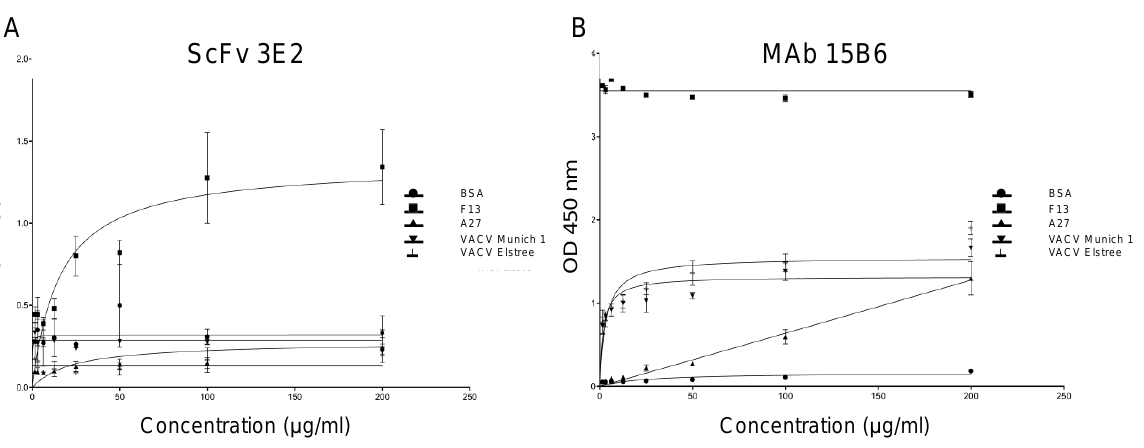
Figure 2. Binding affinities of the scFv 3E2 ( A ) and mAb 15B6 ( B ) as measured in an indirect ELISA using recombinant F13, A27 proteins of VACV, VACV Elstree, Munich1 or BSA. The scFv 3E2 showed a reaction with the recombinant F13 protein. However, the Ab is neither bound to VACV Elstree, VACV Munich1 nor to BSA and A27; the latter were used as negative controls. The mAb 15B6 showed a reaction with the recombinant F13 protein, VACV Elstree and Munich1, while no binding was observed with the recombinant A27 protein and with BSA. Western blotting analysis revealed the binding of the scFv 3E2 on the recombinant F13 protein of VACV under denaturing and reducing conditions (Figure 3A), while no reaction was observed with the VACV Elstree, VACV Munich1 and the A27 protein. As the antibody-positive control, the mAb 5B4/2F2, directed against the A27 protein, was used and showed reactivities with VACV Elstree, VACV Munich1 and the recombinant A27 protein of VACV (Figure 3B).